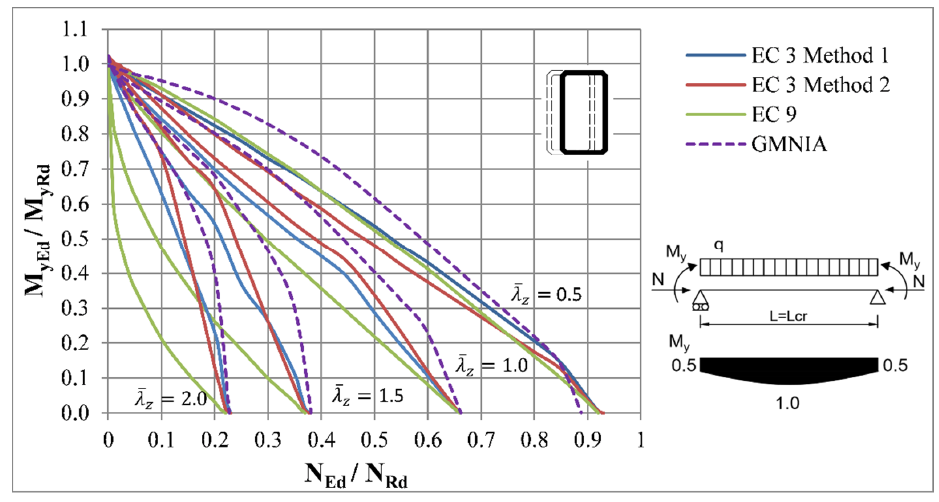
Figure 42. Interaction curves for beam-columns with RHS cross-section without lateral restraints.